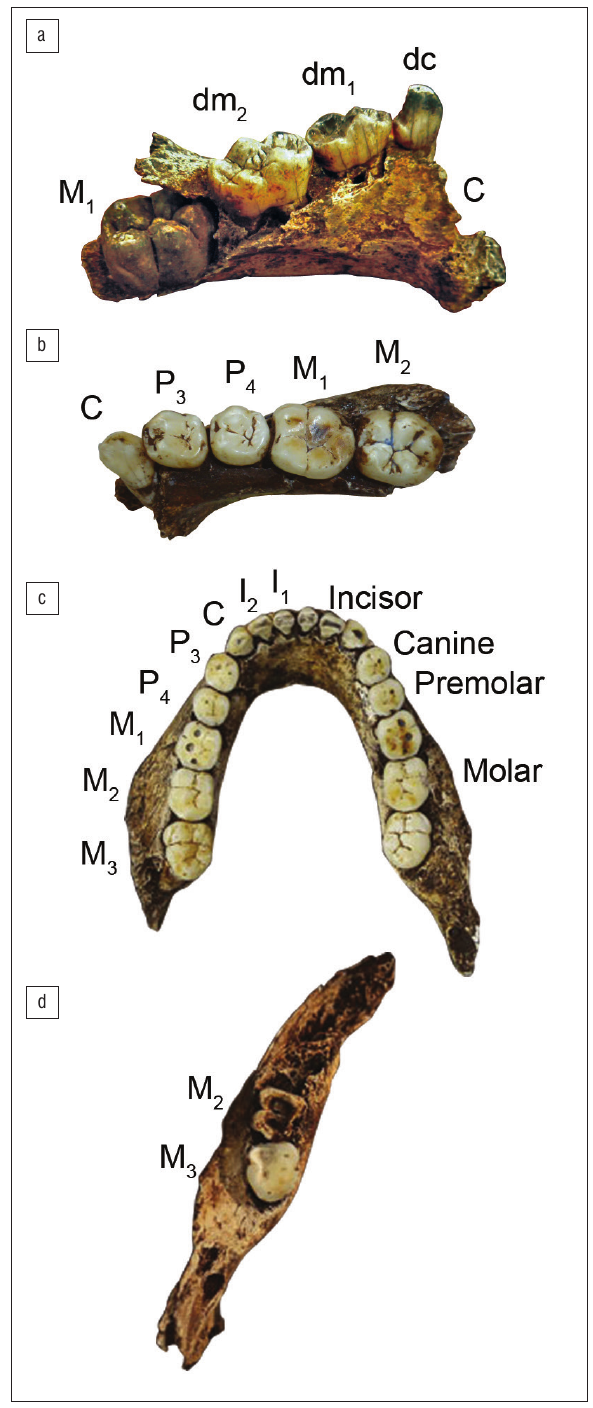
Figure 1: (from top to bottom, not to scale) (a) U.W.101-1400 infant left partial mandible with deciduous teeth and M crypt (unerupted). (b) U.W.101-377 late juvenile right partial mandible with permanent erupted teeth labelled. (c) U.W.101- 1261 adult full mandible with all permanent teeth labelled. (d) U.W.101-361 old adult left partial mandible with permanent teeth very